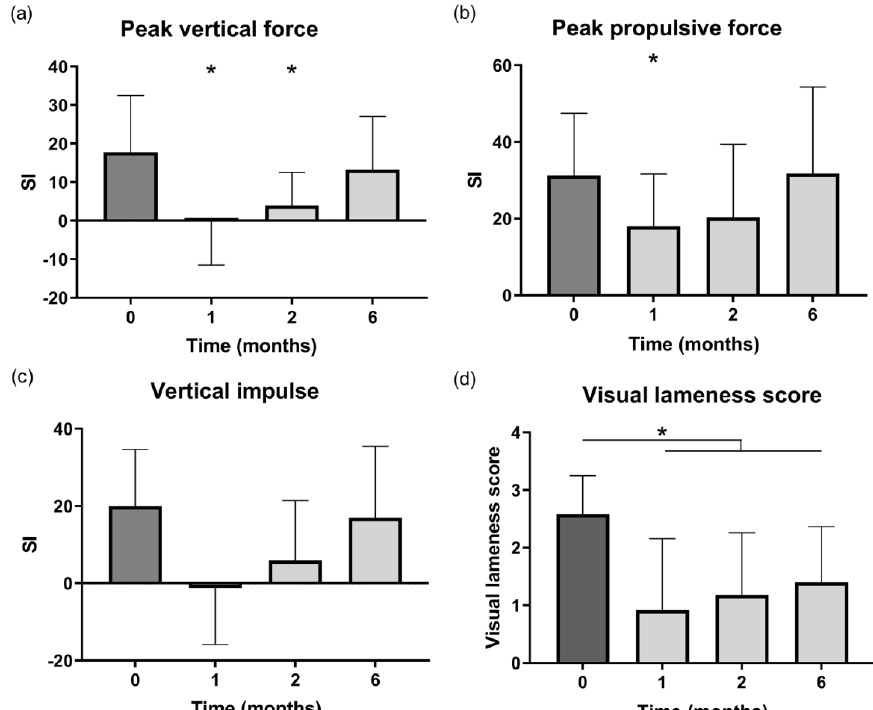
Figure 5. Results of force plate analysis before and 1, 2 and 6 months after intra-articular injection with triamcinolone acetonide-loaded microspheres. ( a ) The symmetry index (SI) of the peak vertical force ( a ) was improved at one and two months post injection ( p = 0.04, p = 0.027) compared to baseline. ( b ) The peak propulsive force was improved at the one-month follow-up ( p = 0.041). ( c ) There was a borderline significant decrease in vertical impulse SI at one and two months post treatment ( p = 0.053, p = 0.062). ( d ) The visual lameness score was significantly lower compared to baseline during the entire study period. * Indicates significantly different from baseline ( p <